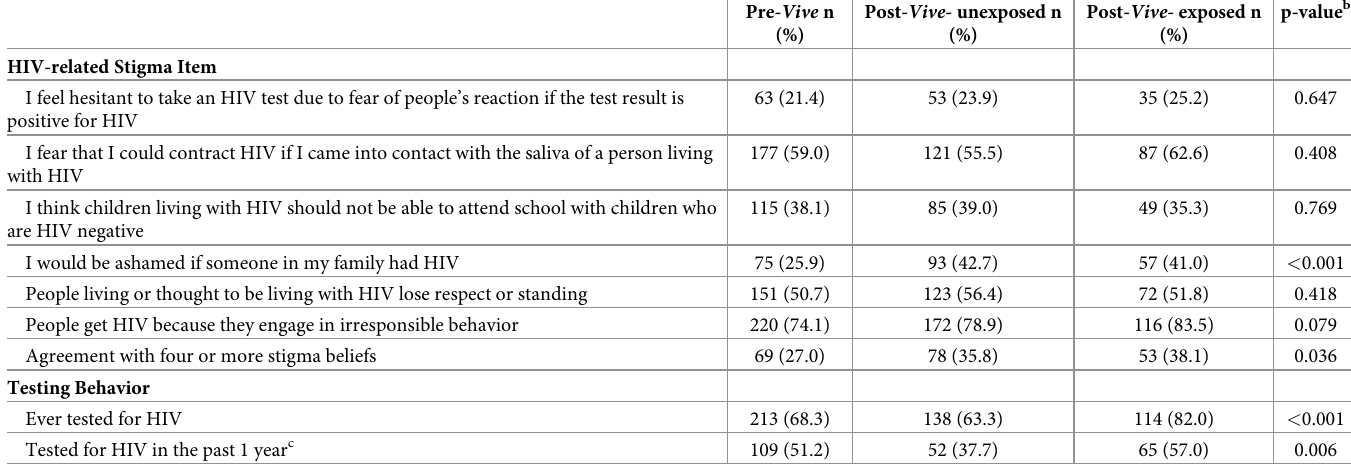
Table 2. Agreement a with HIV-related stigma beliefs and self-reported testing behaviors among pre- Vive (n = 312), post- Vive -unexposed (n = 218), and post- Vive - exposed (n = 139) survey respondents.